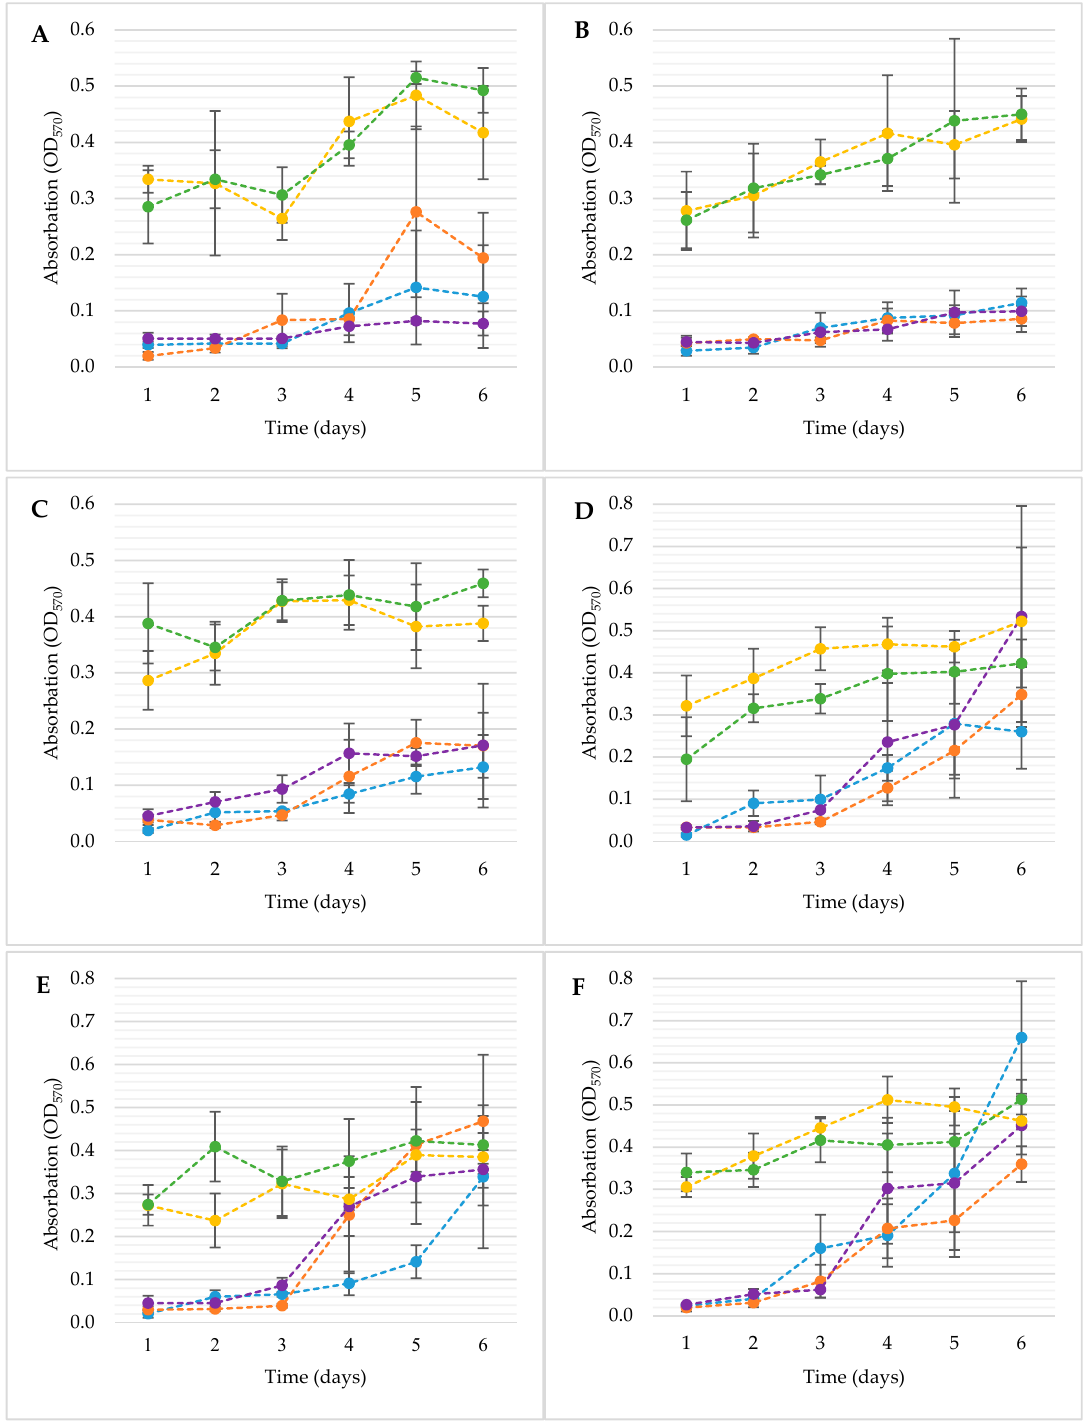
Figure 4. Formation of biofilms by E. coli ATCC 10536 ( A ); E. coli O157:H7 ( B ); E.coli ATCC 25922 ( C ); S. enteritadis ATCC 13076 ( D ); S. enteritadis ATCC 29631 ( E ); S. hofit IFM 2318 ( F ) on the surface of 24-well microplate for 6 days at 22 °C. C—control, not disinfected with any method; D1—disinfected with the 1st method; D2—disinfected with the 2nd method; DP1—disinfected with the 1st method + L. plantarum 299v; DP2—disinfected with the 2nd method + L. plantarum 299v; C — ● ; D1— ● ; D2— ● ; DP1— ● ; DP2— ● ; n = 4.